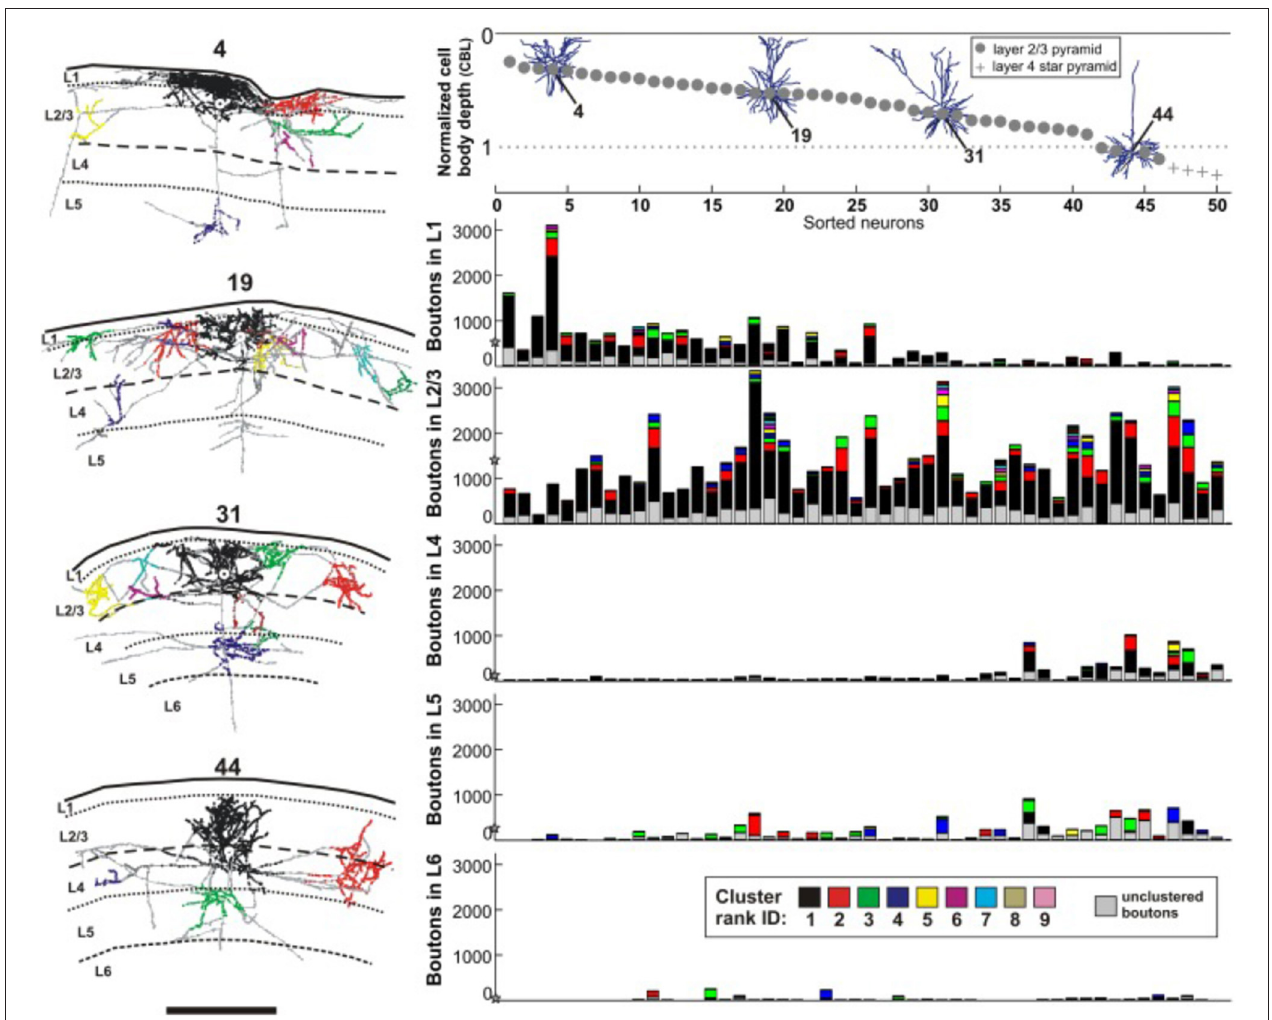
FIGURE 1 | Reconstructions, at left, of four intracellularly filled supragranular neurons in cat V1 (neuron 4, 19, 31, 44), at variable depths from the pia surface. Laminar distribution and spatial spread of boutons are non-stereotyped. Views are for coronal sections, with the home clusters in black. Schematic at upper right depicts the same four neurons in relation to depth from the pia surface, where each neuron is given a specific identity along the x-axis. Below, five histograms for each of five cortical layers (L1, L2/3, L4, L5, L6) where the number of encountered boutons per layer is plotted along the y-axis. The mean number of boutons per layer is depicted with a star on the y-axis. Scale bar = 1.0mm. From Martin et al., 2017 (their figure